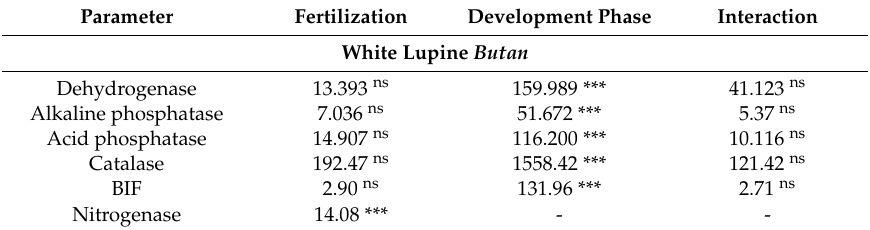
Table 4. The test F statistics and the significance levels of the two-way analysis of variance for the soil bioactivity. The traits under analysis were a ff ected by two factors, i.e., foliar fertilization and the term of the